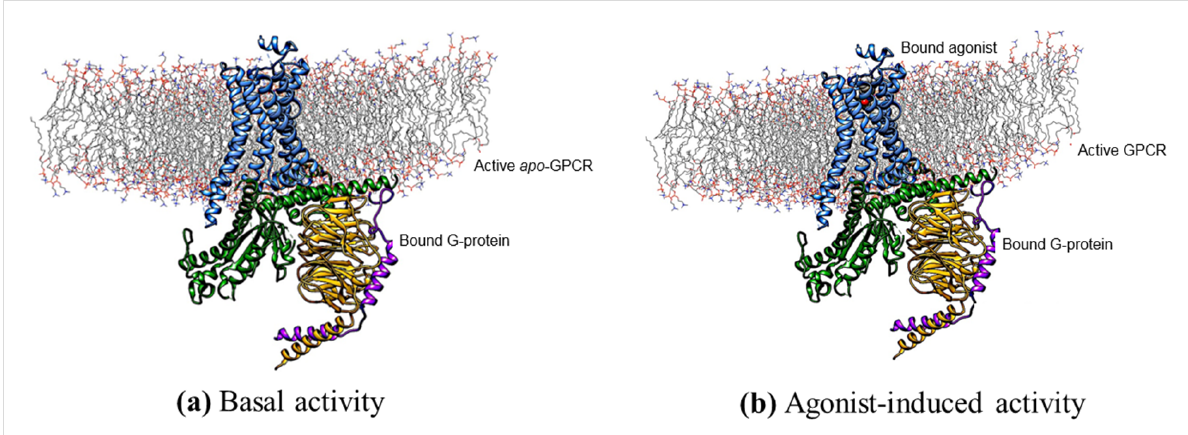
Figure 3: (a) The inactive state of a GPCR: No ligand is bound. The α -subunit of the G-protein is shown in green, β in yellow and γ in magenta. In this state, the GPCR exhibits basal activity. This figure assumes pre-association of the G-protein to the receptor. (b) Fully activated GPCR. Both an agonist ligand and the G-protein are required for full activation. The structures shown are based on homology models.